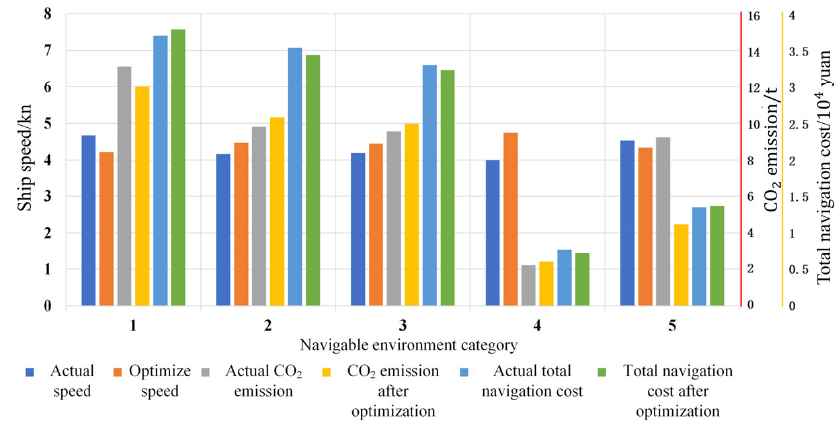
Figure 11. Comparison of the actual values and the multi ‐ objective optimization values.